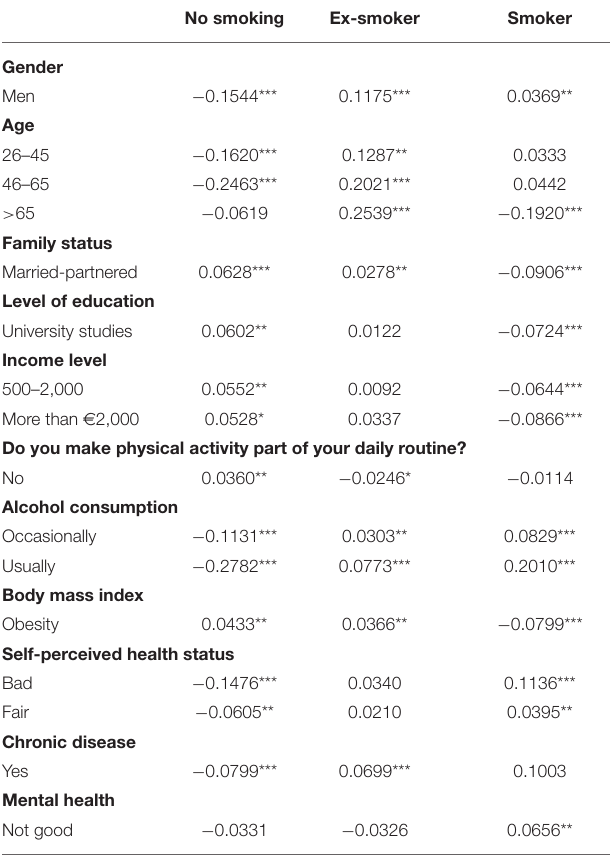
TABLE 3 | Discrete changes of the multinomial logit model.